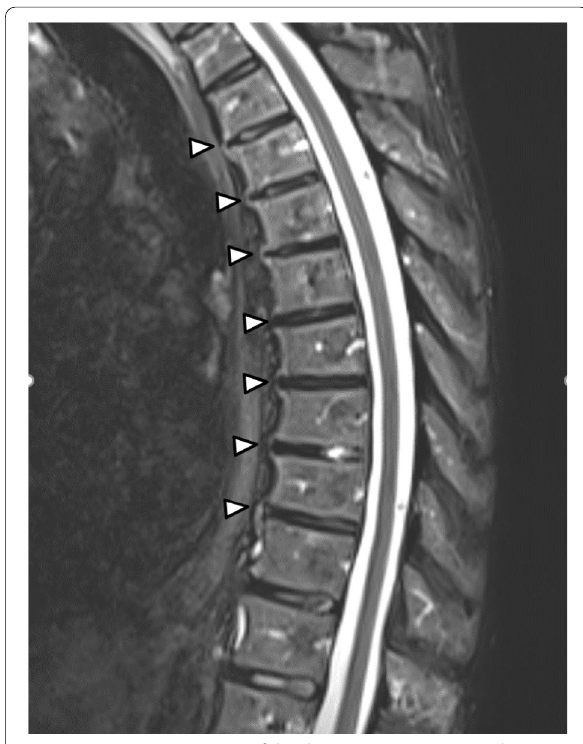
Fig. 4 MRI (TIRM sequence) of the thoracic spine. Image in the sagittal plane in a patient (male, 61 years old) diagnosed with axial SpA. Multiple thoracic anterior syndesmophytes are depicted (white